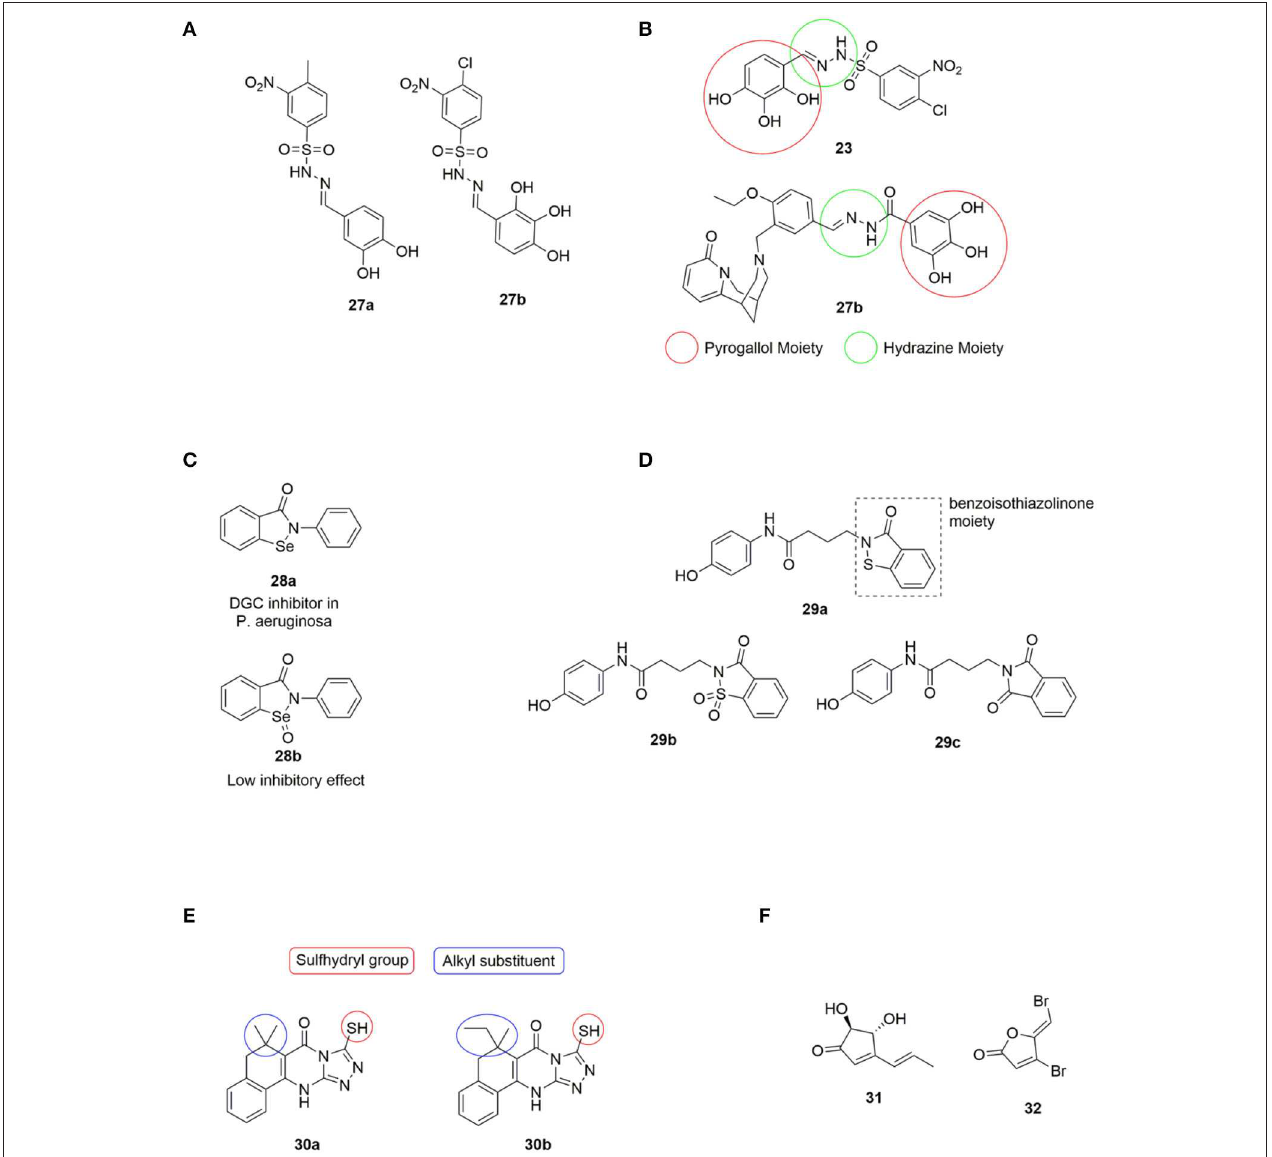
FIGURE 6 | (A) DGC inhibitors investigated by Rinaldo et al., all significantly reduced PleD activity. Amb379455 27b being the most promising (Fernicola et al., 2016). (B) Structual comparison of LP3134 23 and Amb379455 27b. (C) The small molecule ebselen (Eb) 28a identified as an DGC inhibitor by Lee and coworkers, and its oxidized form ebselen oxide (EbO) 28b (Lieberman et al., 2014). (D) 29a discovered by the Sintim group, and further investigated the importance of the benzoisothiazolinone moiety by testing 29b and 29c (Zheng et al., 2016). (E) H19 30a and 925 30b ; two Alg44 (pilZ domain) inhibitors identified by Wang et al., and structural features further investigated by Zhou et al. (2017). (F) The small molecules terrein 31 and 32 used by Kim et al. in studying the correlation between regulation of c-di-GMP levels and QS.